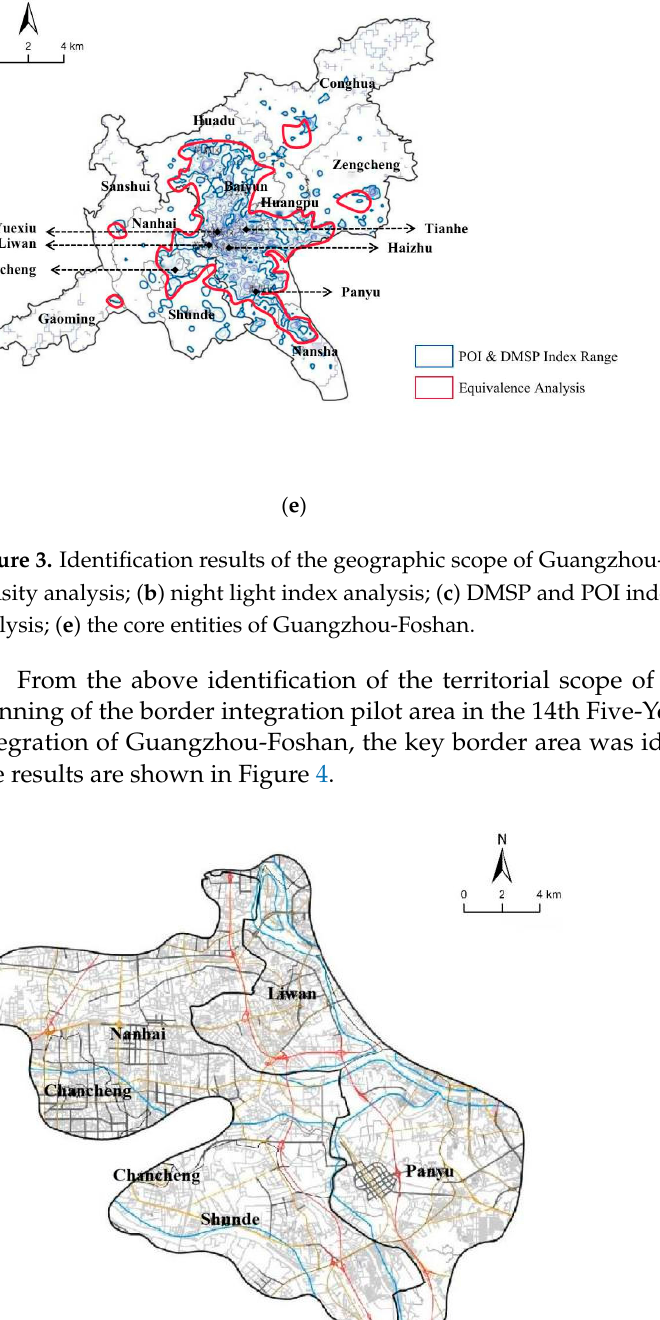
Figure 4. Delineating key border area of Guangzhou-Foshan development.